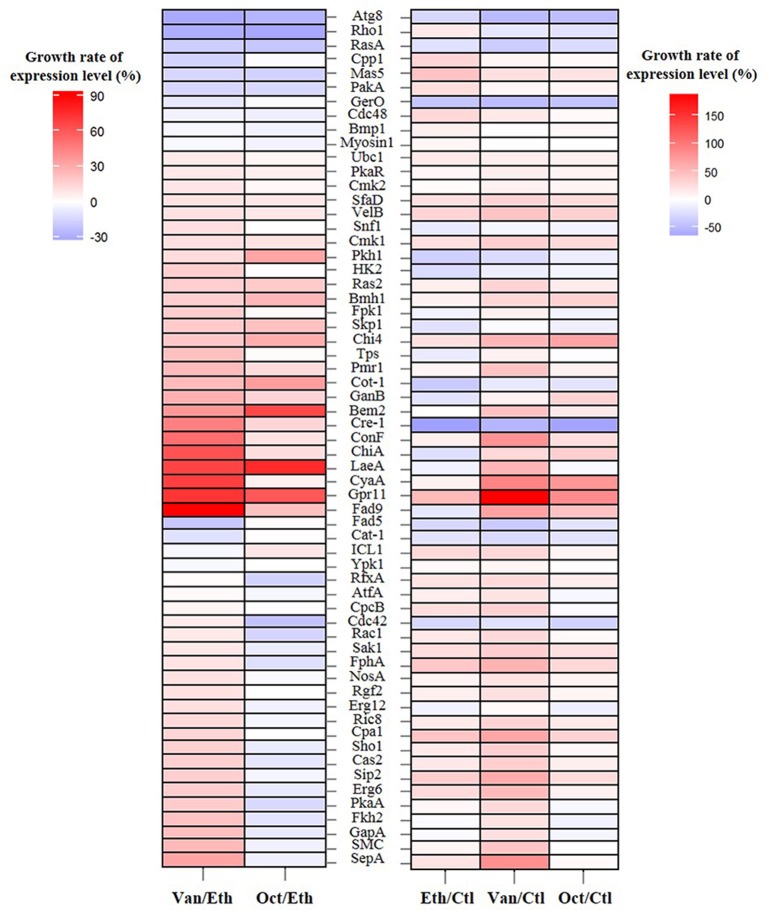
Growth rate of the expression levels of 61 germination-related proteins in A. camphorata arthroconidia by iTRAQ-based proteomic analysis. Growth rate of the expression level of specific gene was calculated according to the following equation: [(% expression level of gene in compound-treated group/% expression level in control (or ethanol-treated) group)−1] × 100. Ctl, control group of non-germinated arthroconida; Eth, ethanol-treated arthroconidia after 24 h of incubation; Van, vanillin-treated arthroconidia after 24 h of incubation; Oct, 1-octen-3-ol-treated arthroconidia after 24 h of incubation.